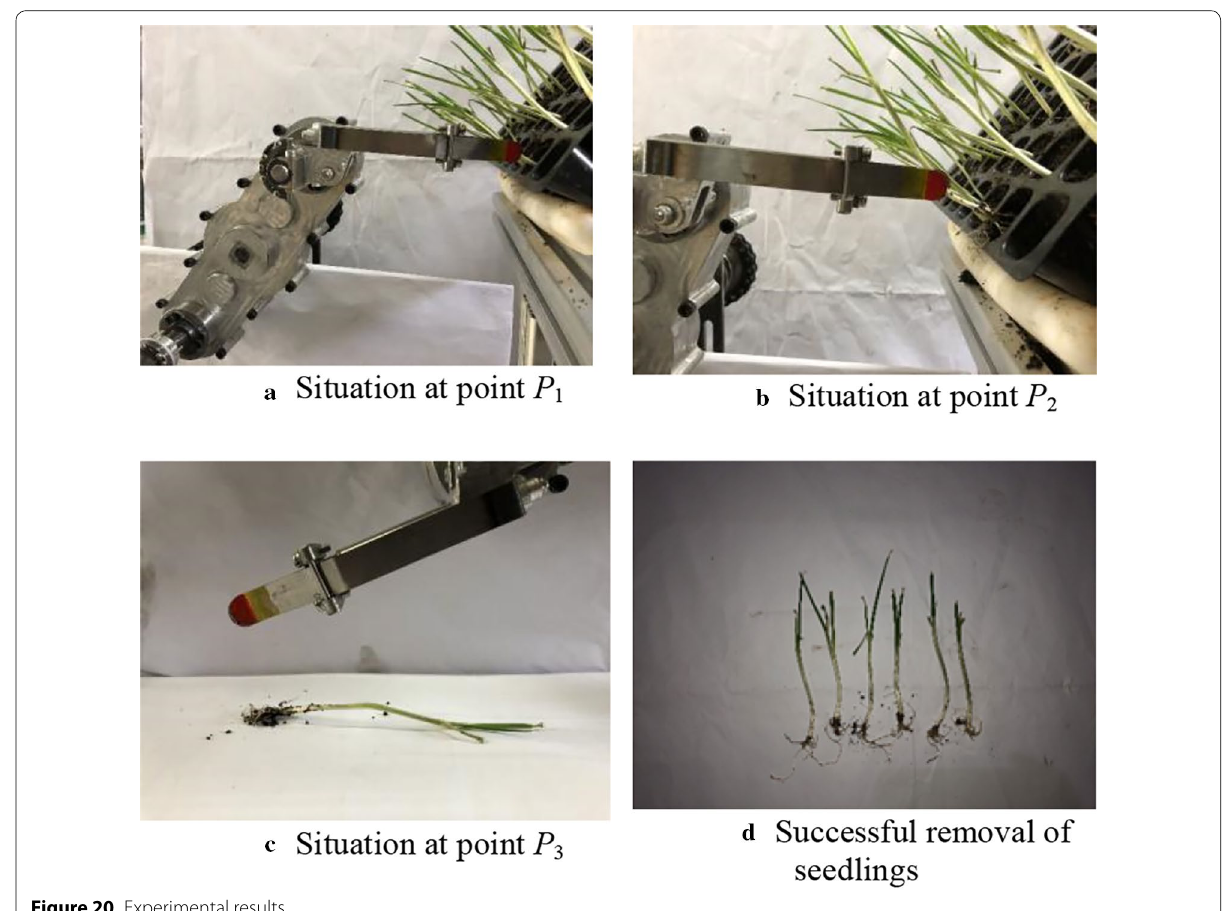
Figure 20 Experimental